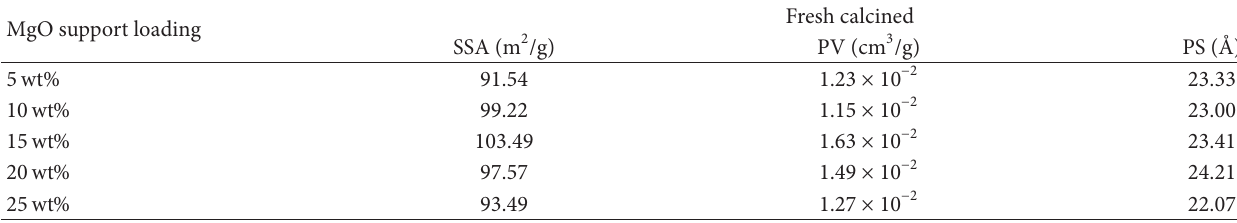
SSA: speci�c surface area� PV: pore volume� PS: pore